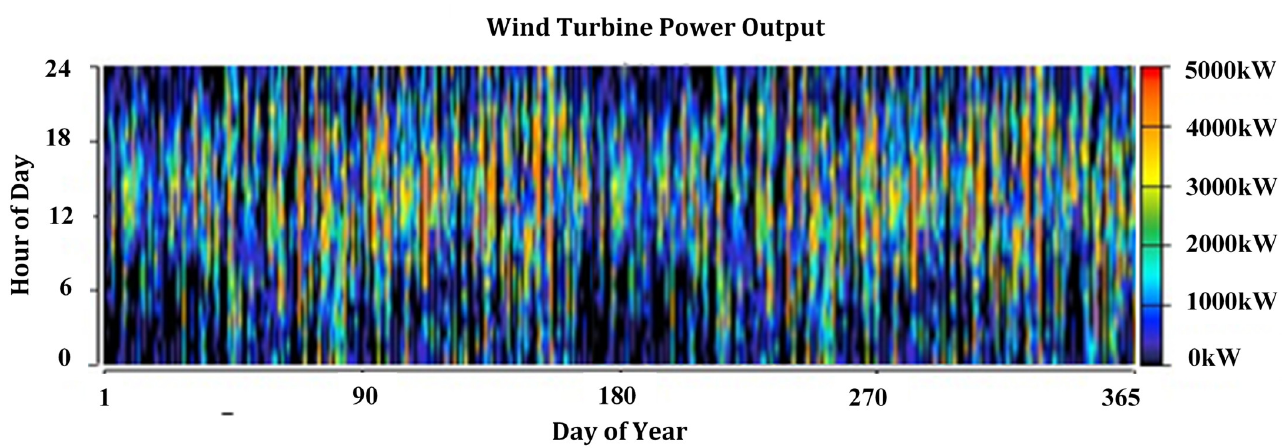
Figure 24. Annual Wind turbine generator operation.